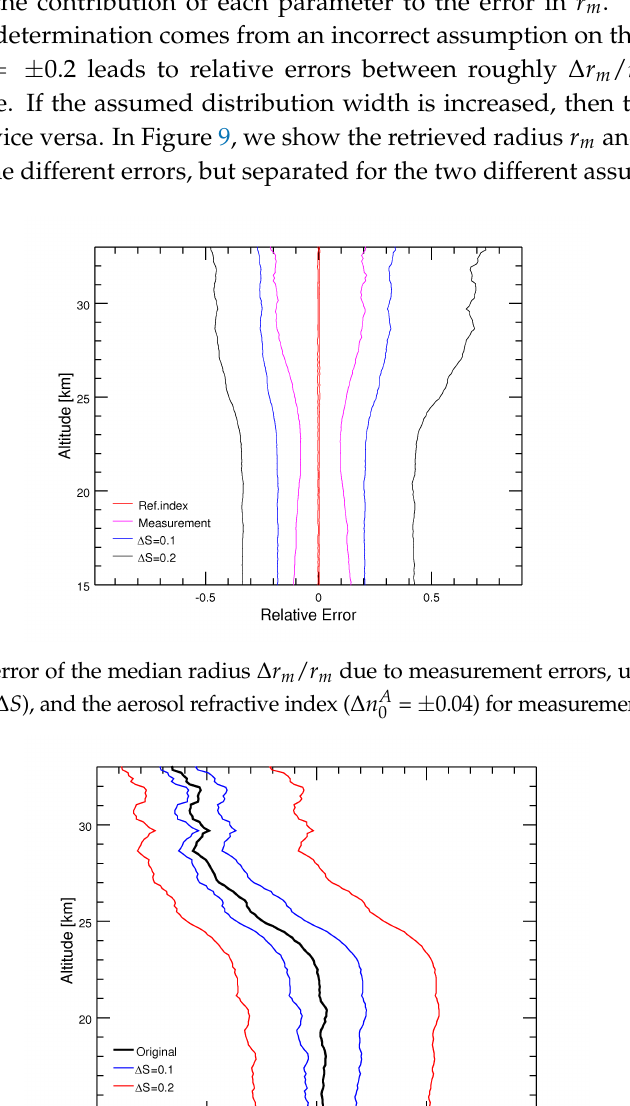
Figure 9. Median radius ( r m ) profile for March 2013 inferred with an assumed distribution width of S = 1.5 (black curve). The error ranges are obtained by adding the error contributions of measurement uncertainty, refractive index variation, and uncertainties in the distribution widths (red and blue